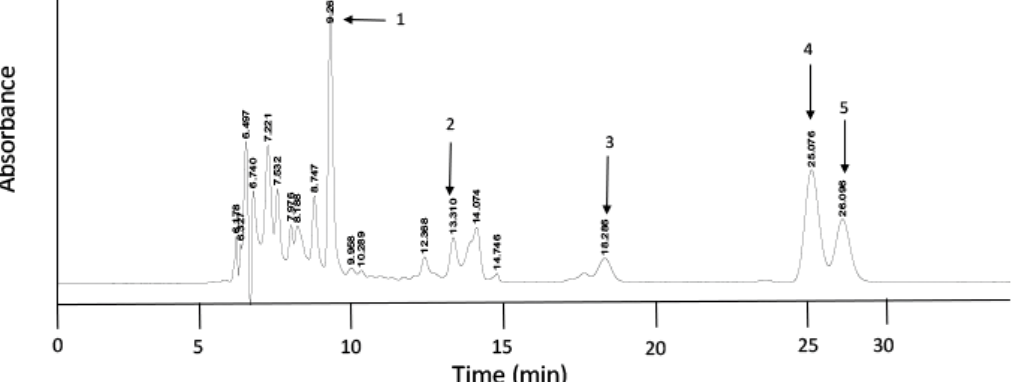
Figure 2. HPLC elution profile recorded at 460 nm showing the separation of the β -carotene and the geometric isomers of lycopene from an extract of plasma taken from a non-smoker: β -carotene (1); (13 Z )-lycopene (2); (9 Z )-lycopene (3); (all- E )-lycopene (4); and (5 Z )-lycopene (5). The details for the extraction and separation are described in the methods section.